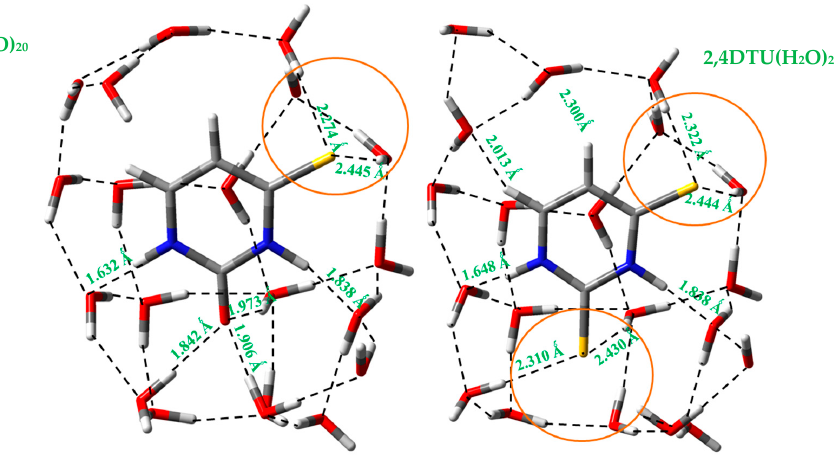
(i) A slight di ff erence in the distribution of water molecules around the sulphur atoms as compared to that around the oxygen atoms, as indicated in a circle in orange color in Figure